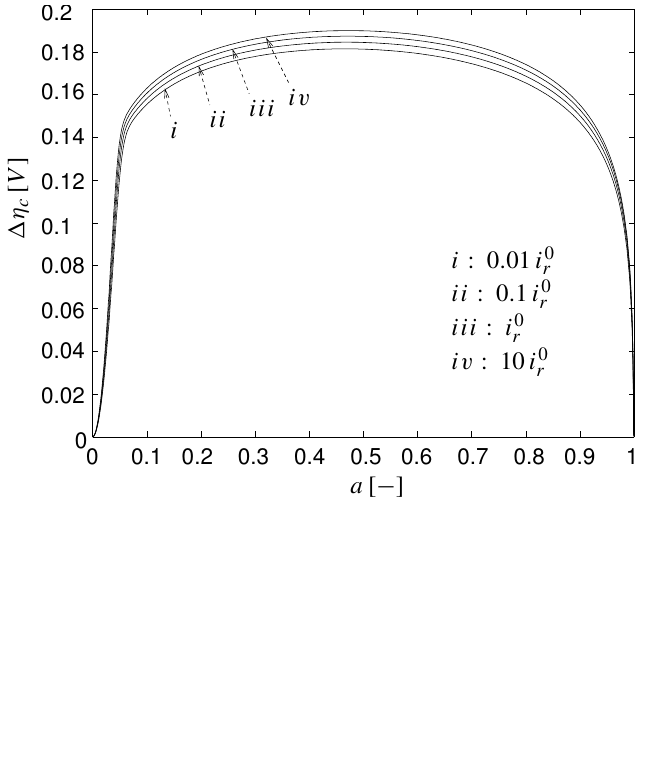
Figure 15. Stationary oscillation amplitudes ∆ η buck converter’s duty ratio a at different values of ˆ α .